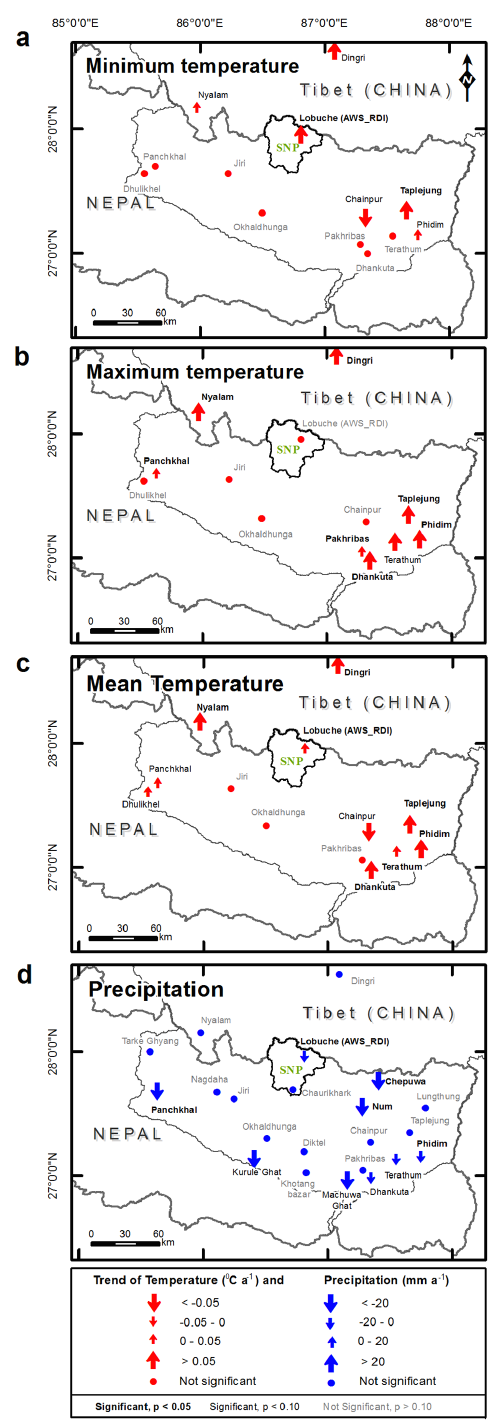
Figure 6. Spatial distribution of the Sen’s slopes in the Koshi Basin for minimum (a) , maximum (b) , and mean (c) air temperature and (d) total precipitation for the 1994–2013 period. Data are reported in Table